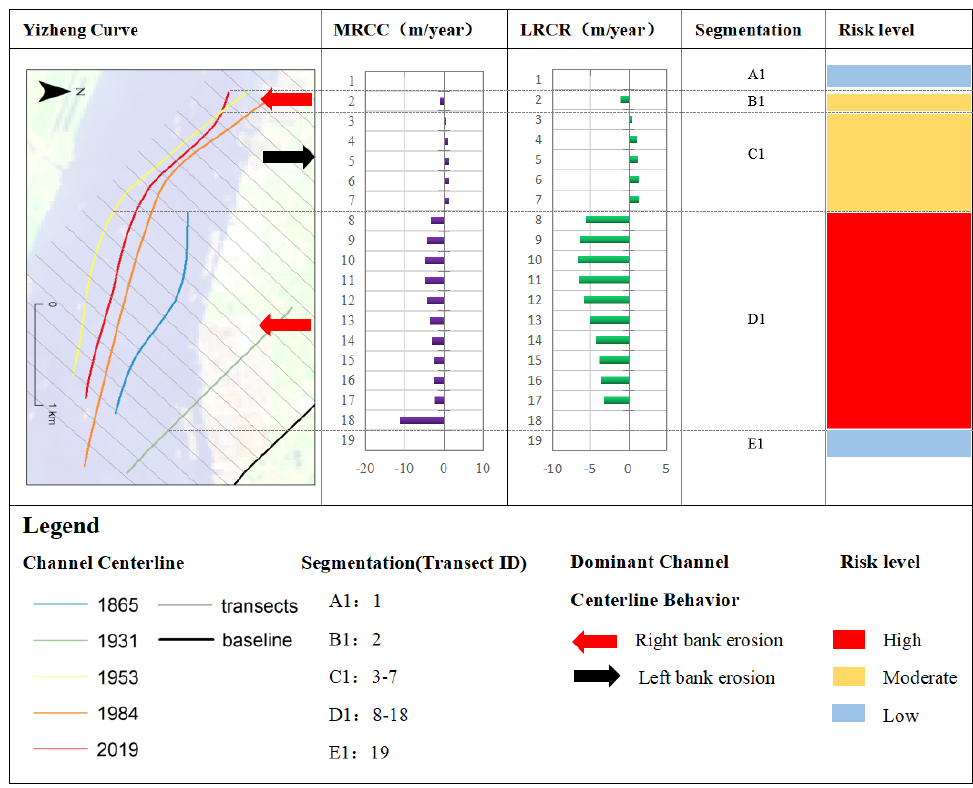
Figure 5. The Migration Rate of Channel Centerline, Linear Regression Change Rate, and erosion risk identification on Yizheng Curve.